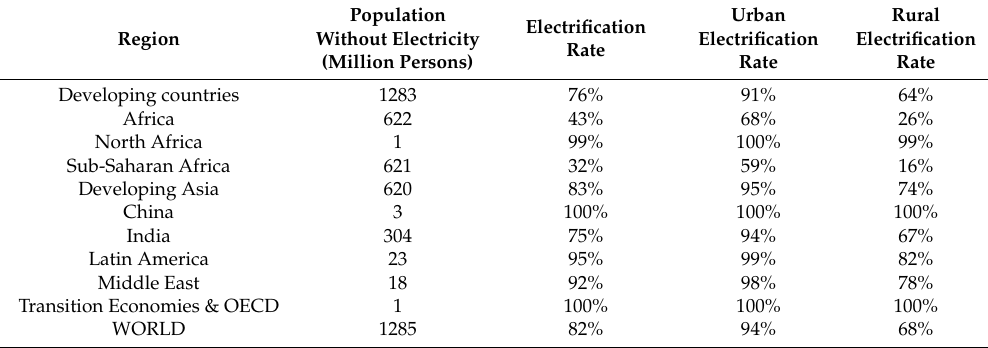
Table 1. Electrification Rates Across Major Regions of the World